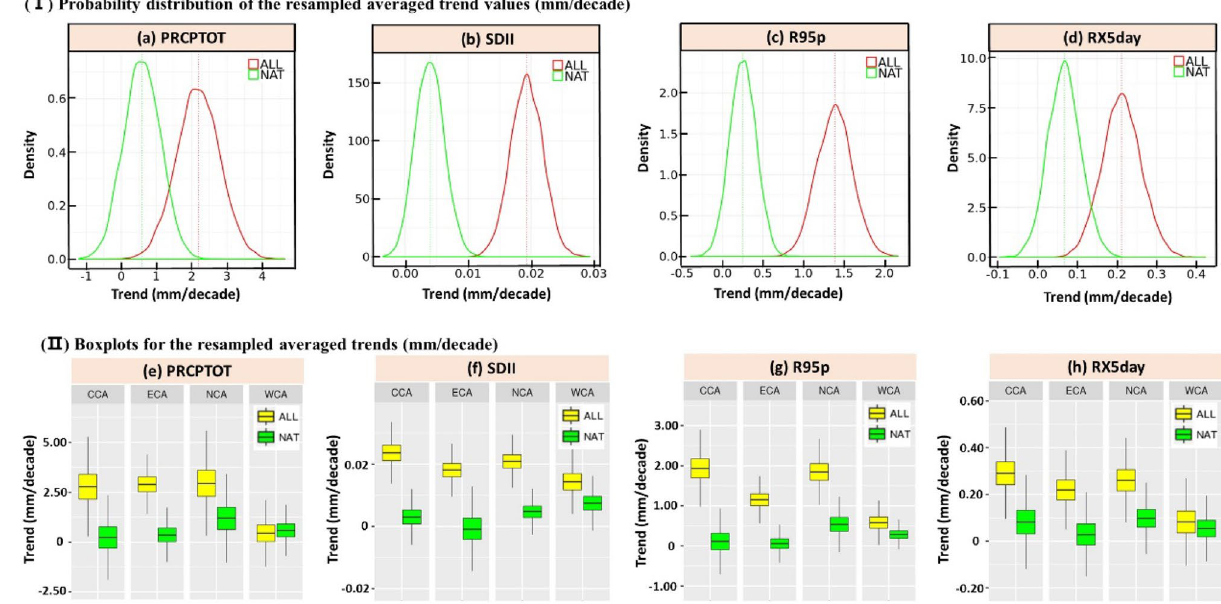
Figure 2. (I) Probability distribution of the resampled averaged trend values (mm/decade) for the PRCPTOT ( a ), SDII ( b ), R95p ( c ) and RX5day ( d ) under the CMIP5 ALL and NAT simulations during the period 1961–2005. The vertical line indicates the median (best estimate) trend value. (II) Boxplots for the resampled averaged trends (mm/decade) for the PRCPTOT ( e ), SDII ( f ), R95p ( g ) and RX5day ( h ) for 4 sub-regions in CA regarding the CMIP5 ALL and NAT scenario obtained by the bootstrapping procedure. The subfigures were done in the software R 4.0.2 (https:// cran.r- proje ct. org/ bin/ windo ws/), and then the subfigures were merged by using the Microsoft PowerPoint 2013 software (https:// www. micro soft.